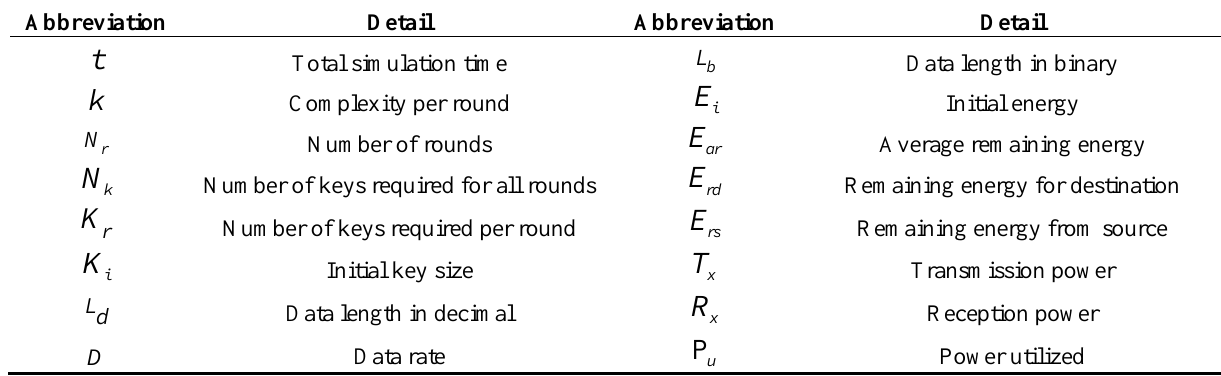
Table 2. List of abbreviations used in performance